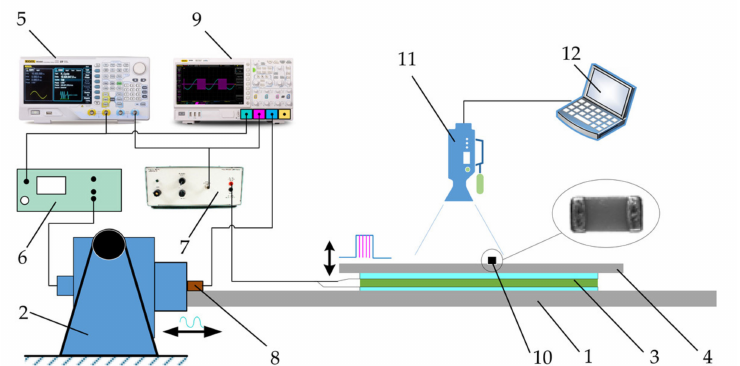
Figure 5. Experimental setup for manipulation of microminiature bodies employing dry friction control: (1), platform; (2), electrodynamic shaker; (3), piezoelectric actuator; (4), manipulation surface; (5), arbitrary waveform generator; (6), power amplifier; (7), piezo linear amplifier; (8), vibration sensor; (9), digital oscilloscope; (10), body to be manipulated (MLCC); (11), high-speed camera; (12),